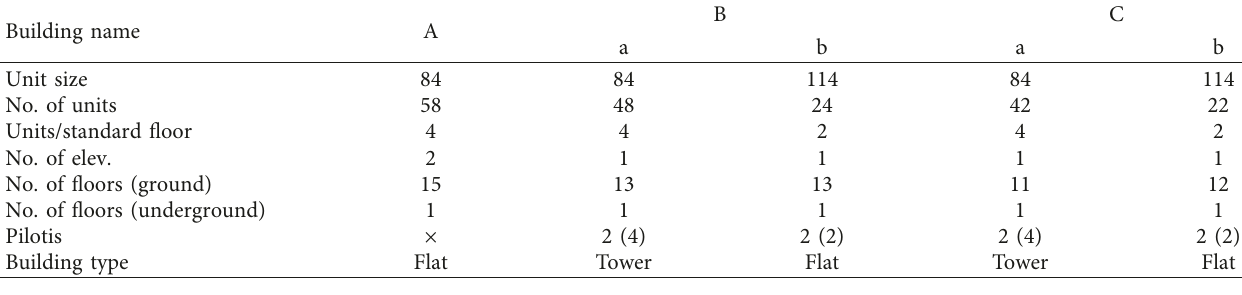
Table 5: Profiles of validation cases.